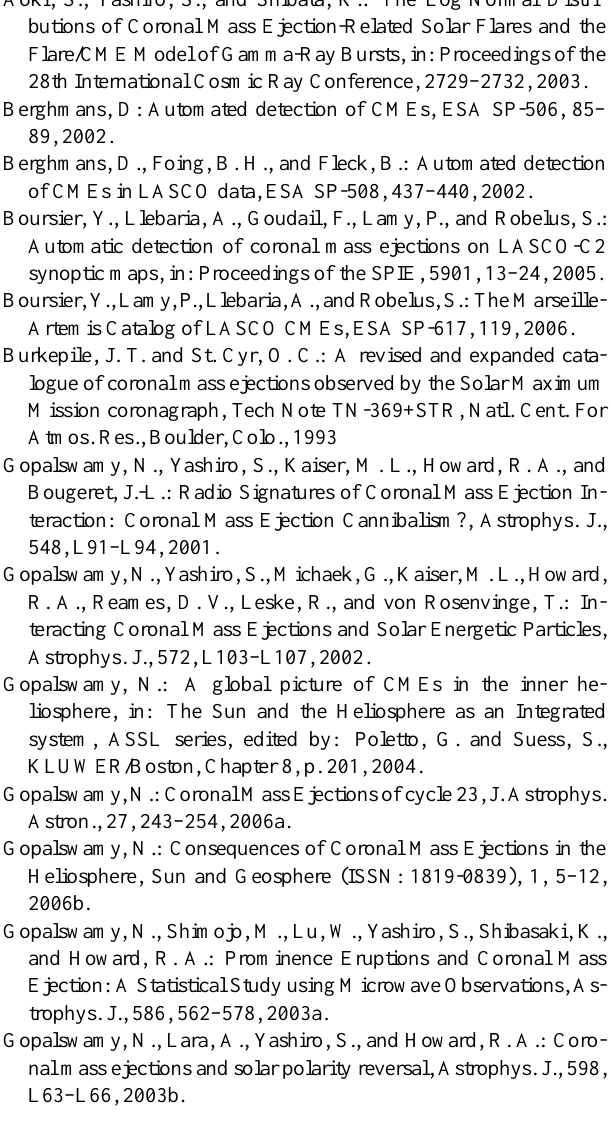
Fig. 7. Daily rate of fast wide CMEs and X-class flares. Red and blue lines are for the CDAW and CACTus catalogs, respectively, and Green shade is for the X-class flares (left scale). Black lines are smoothed monthly sunspot number (right scale) for the reference of the solar